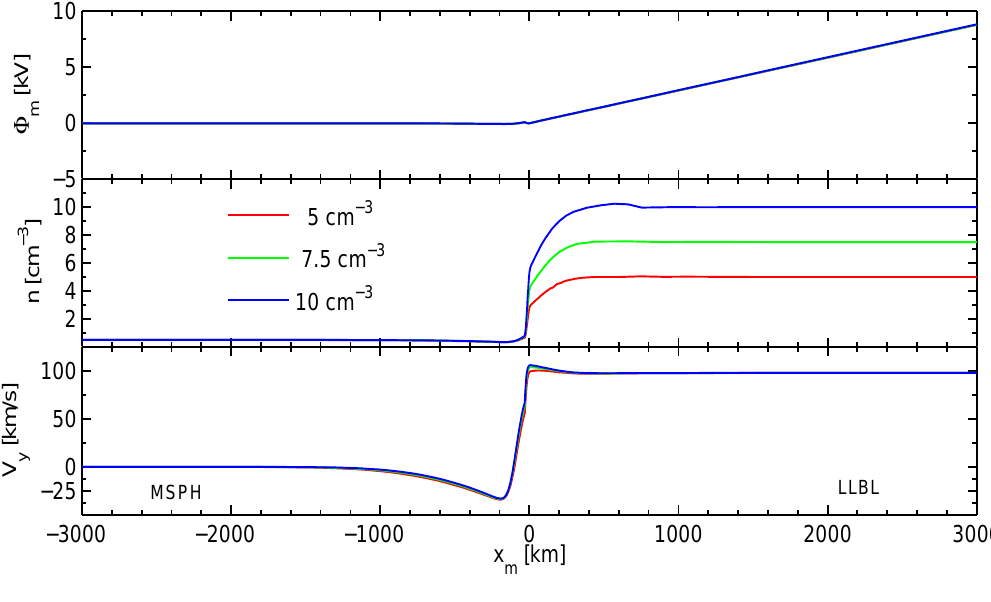
Fig. 3. Kinetic tangential discontinuity solution obtained for different values of the LLBL density (right side of the discontinuity); see caption of Fig. 2 for a description of the different panels.